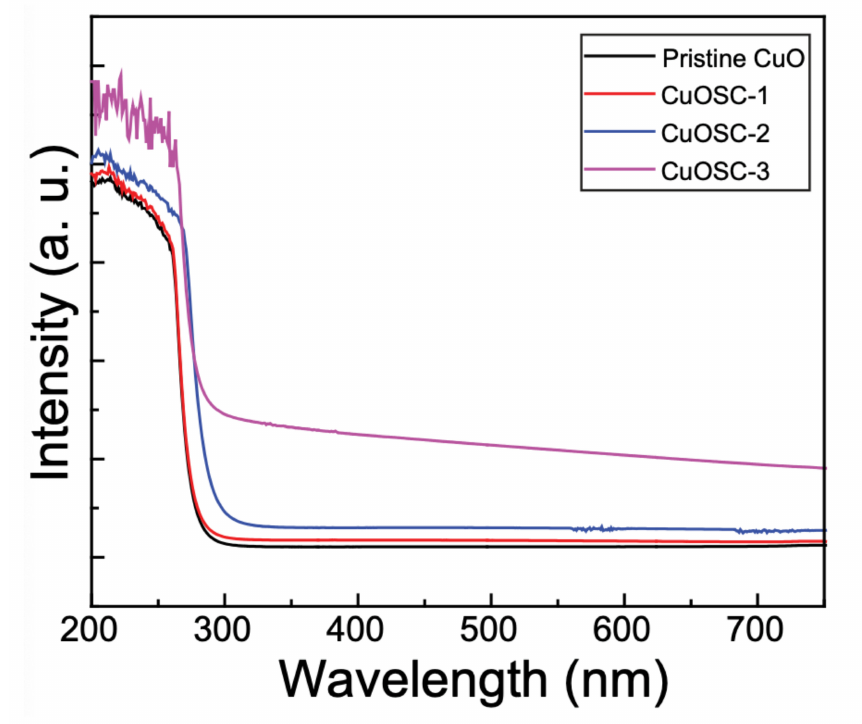
Figure 5. UV–vis diffuse-reflectance spectra displaying the improvement in optical absorbance range of pristine CuO owing to the formation of heterojunction with